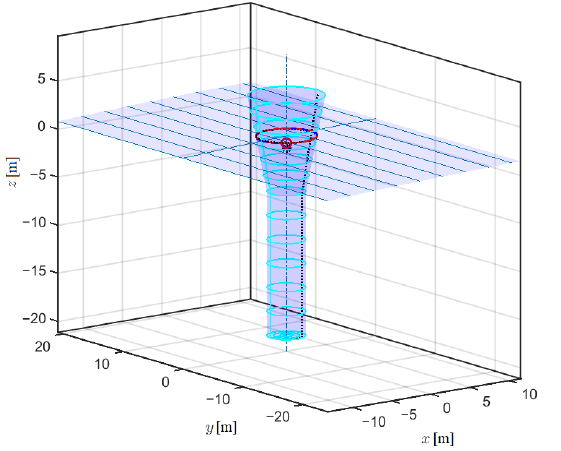
Figure 11. The buoy geometry visualised in the NLFK4ALL toolbox, which analytically recalculates the Froude–Krylov force at each time step from the evolving submerged surface area of the buoy based on the instantaneous buoy position and wave